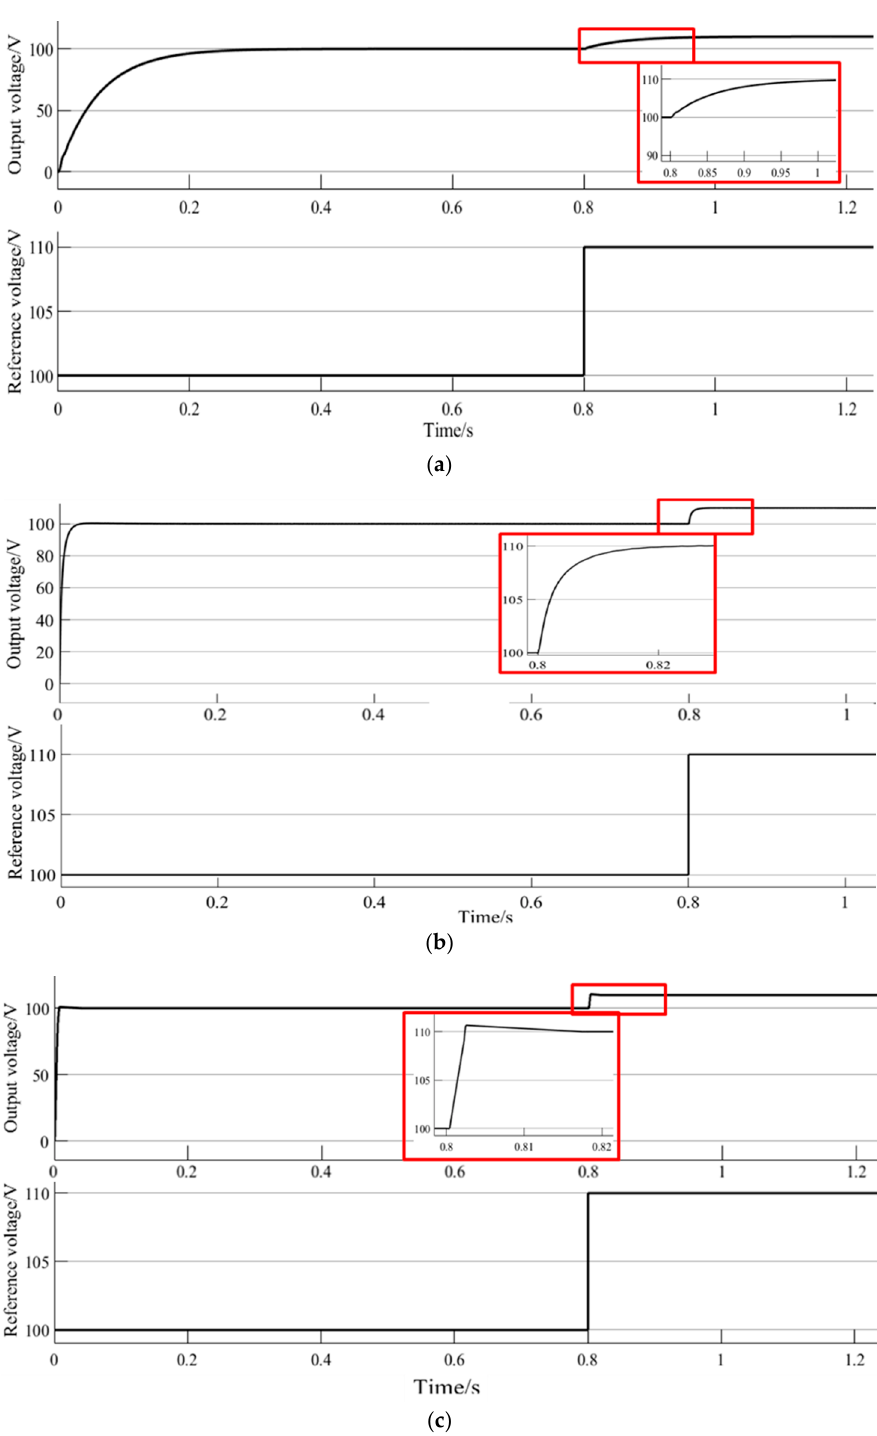
Figure 14. System output response under different control strategies. ( a ) Voltage feedback control system output; ( b ) feedforward-double feedback control system output; and ( c ) sliding mode control system output.